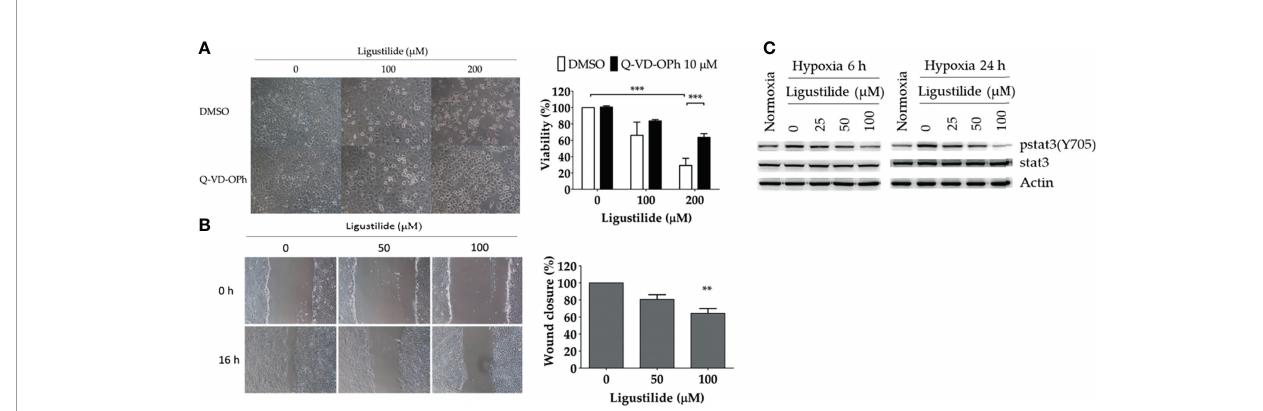
FIGURE 1 | Ligustilide-induced caspase-dependent apoptosis and inhibited cell migration in oral cancer cells. (A) TW2.6 cells were pretreated with the pan-caspase inhibitor Q-VD-OPh (10 m M) for 30 min and incubated with ligustilide for another 24 h of hypoxia at 37°C. Cell viability was measured by MTT assay and images were captured and presented in 200 times magni fi cation. Data in the plot are expressed as mean ± SEM ( n ≥ 3). (B) Ligustilide attenuated cell migration in hypoxic TW2.6 cells. Cells were plated in 12-well plates overnight as a monolayer. A 200- m l tip was used to scratch a gap in the middle of the monolayers. Cells were washed with PBS and incubated with fresh serum-free medium with or without ligustilide and incubated at 37°C of hypoxia for 16 h. Cell migration was measured. Images are presented in 100 times magni fi cation. Data in the plot were expressed as mean ± SEM ( n ≥ 3). (C) Ligustilide reduced phospho-stat3 dose-dependently. TW2.6 cells were treated with ligustilide in different doses and harvested at 6 and 24 h of hypoxia. Protein was analyzed by Western blot. **P-valve < 0.01; ***P-valve < 0.001.